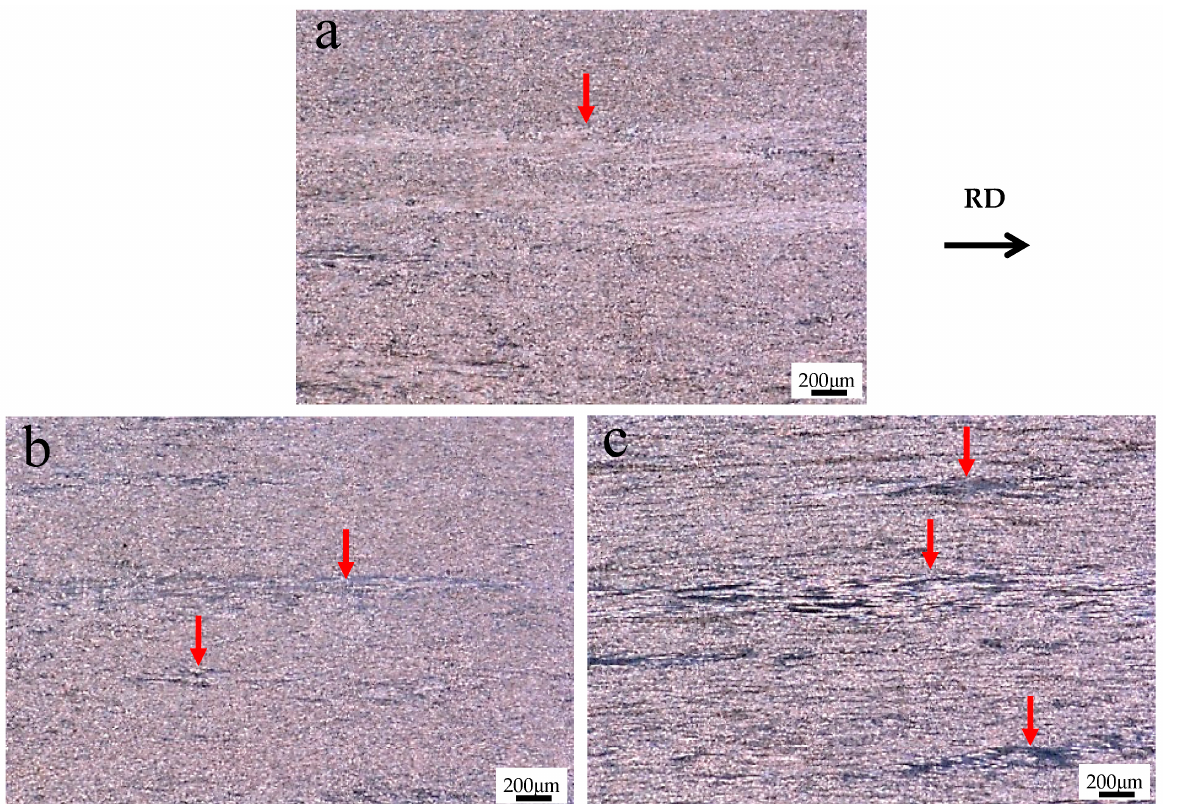
Figure 1. Microstructures of hot-rolled 301 ASS (( a ): 301ASS, ( b ): 301ASS-0.4Cu, ( c ): 301ASS-1.1Cu).